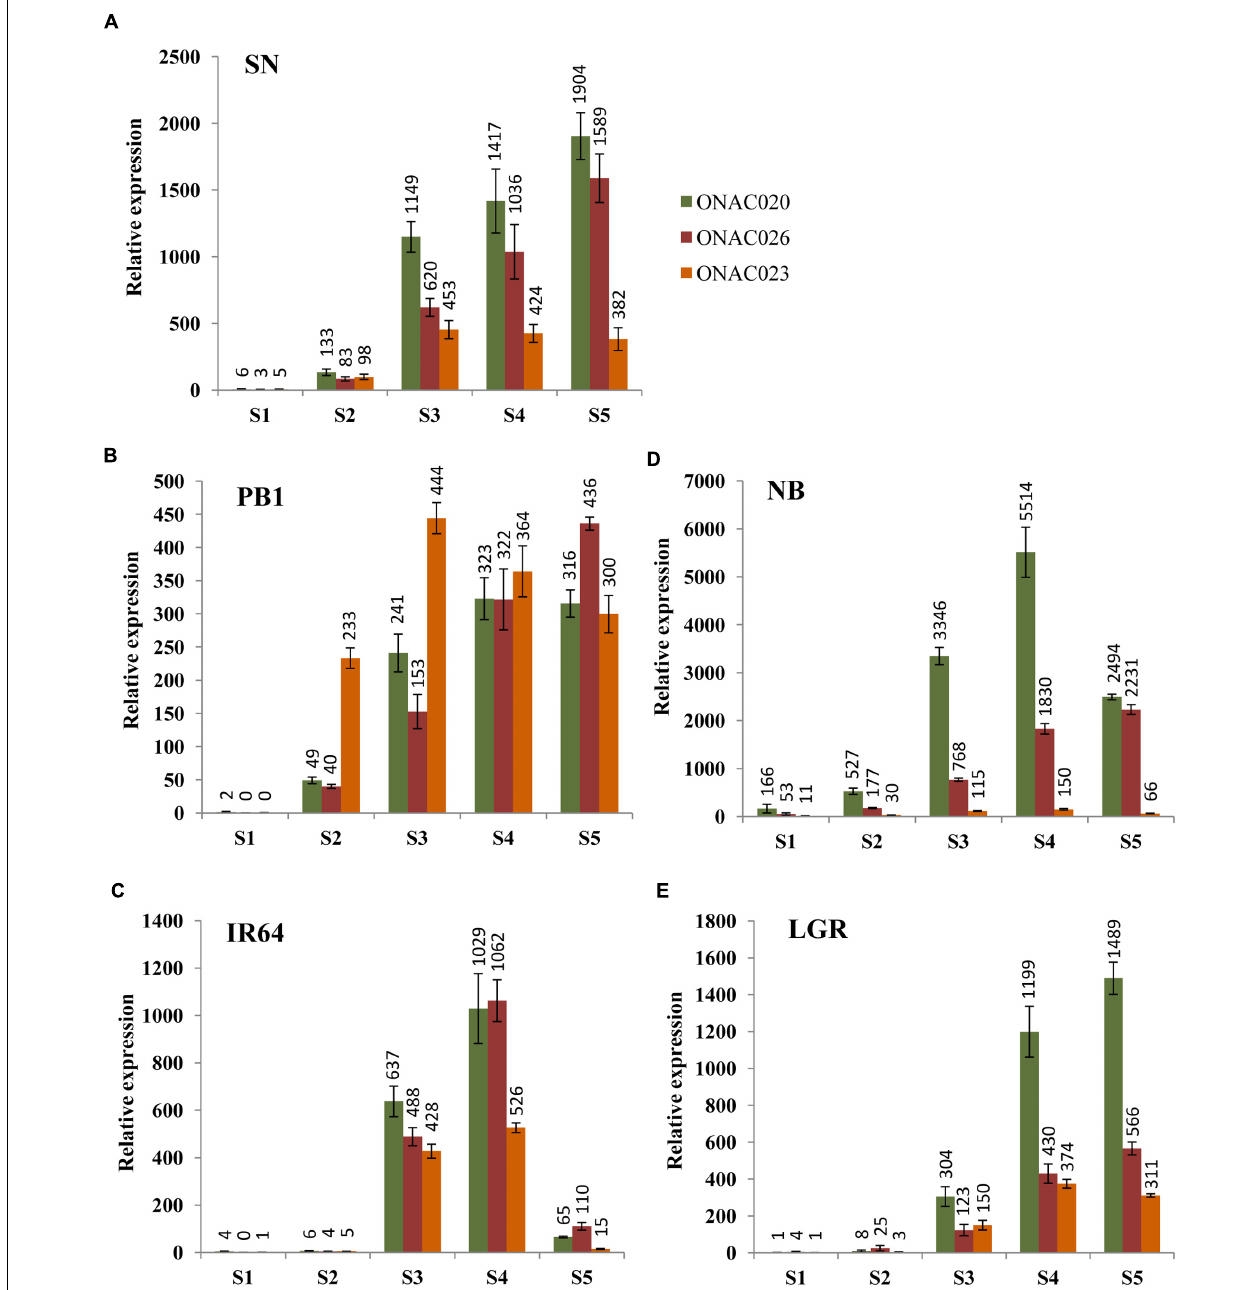
FIGURE 2 | Relative expression levels of three seed-specific NAC genes, namely, ONAC020 , ONAC026 and ONAC023 , in five rice accessions with varying seed weights. The accessions are (A) Sonasal (SN), (B) Pusa Basmati 1 (PB1), (C) indica Rice 64 (IR64), (D) Nipponbare (NB) and (E) Large Grain Rice (LGR), arranged according to increasing weights. The relative expression for each gene, in each accession has been studied in all the five stages of seed development (S1–S5), as mentioned in the color legend in (A)